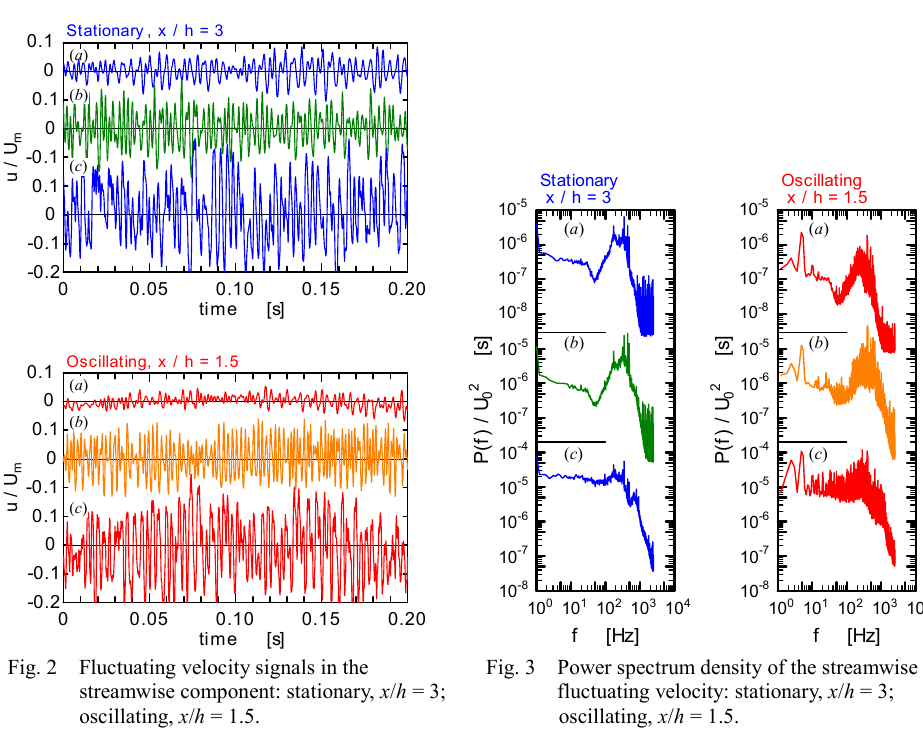
Fig. 2 Fluctuating velocity signals in the Fig. 3 Power spectrum density of the streamwise streamwise component: stationary, x / h = 3; fluctuating velocity: stationary, x / h = 3; oscillating, x / h = 1.5. oscillating, x / h =